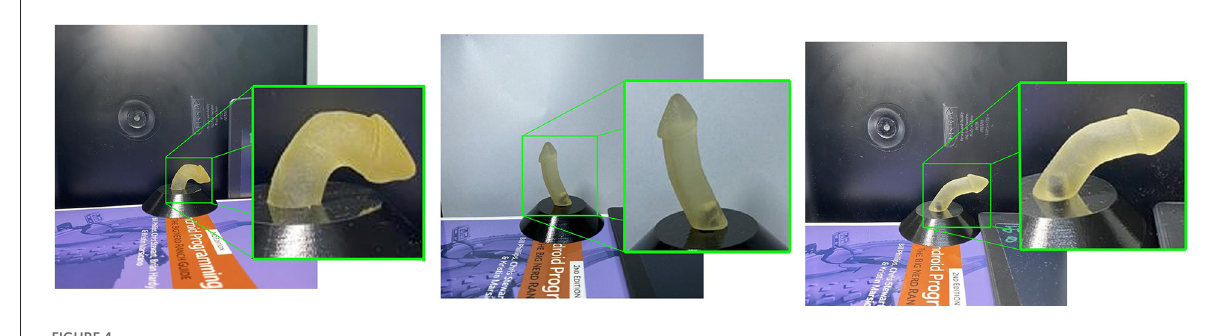
FIGURE4 Sample qualitative evaluation of the cropped penile area.